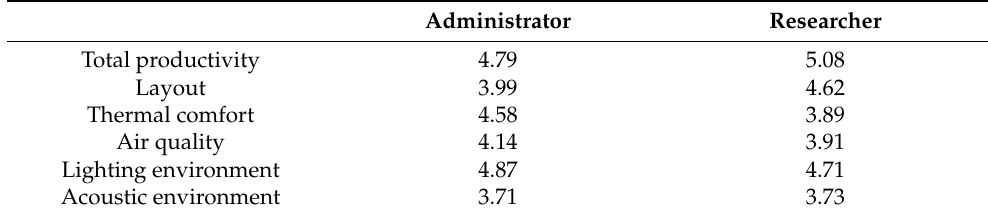
Table 7. Respondents’ perception of productivity in relation to IEQ aspects (Likert 7-point scale).